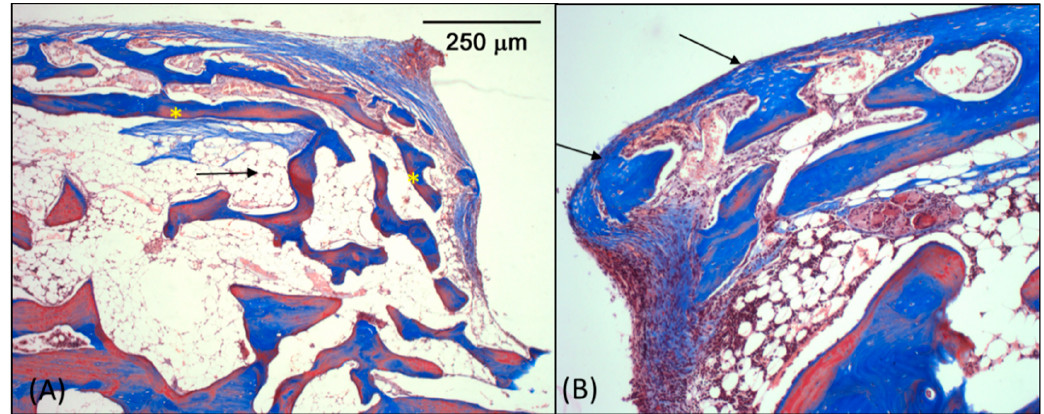
Figure 9. Microscopic images from Group 3: ( A ) Mature bone tissue (*) with well-defined bone trabeculae and marrow spaces (black arrow) filled by active hematopoietic tissue. ( B ) Newly formed bone reaching the limits of the dome.